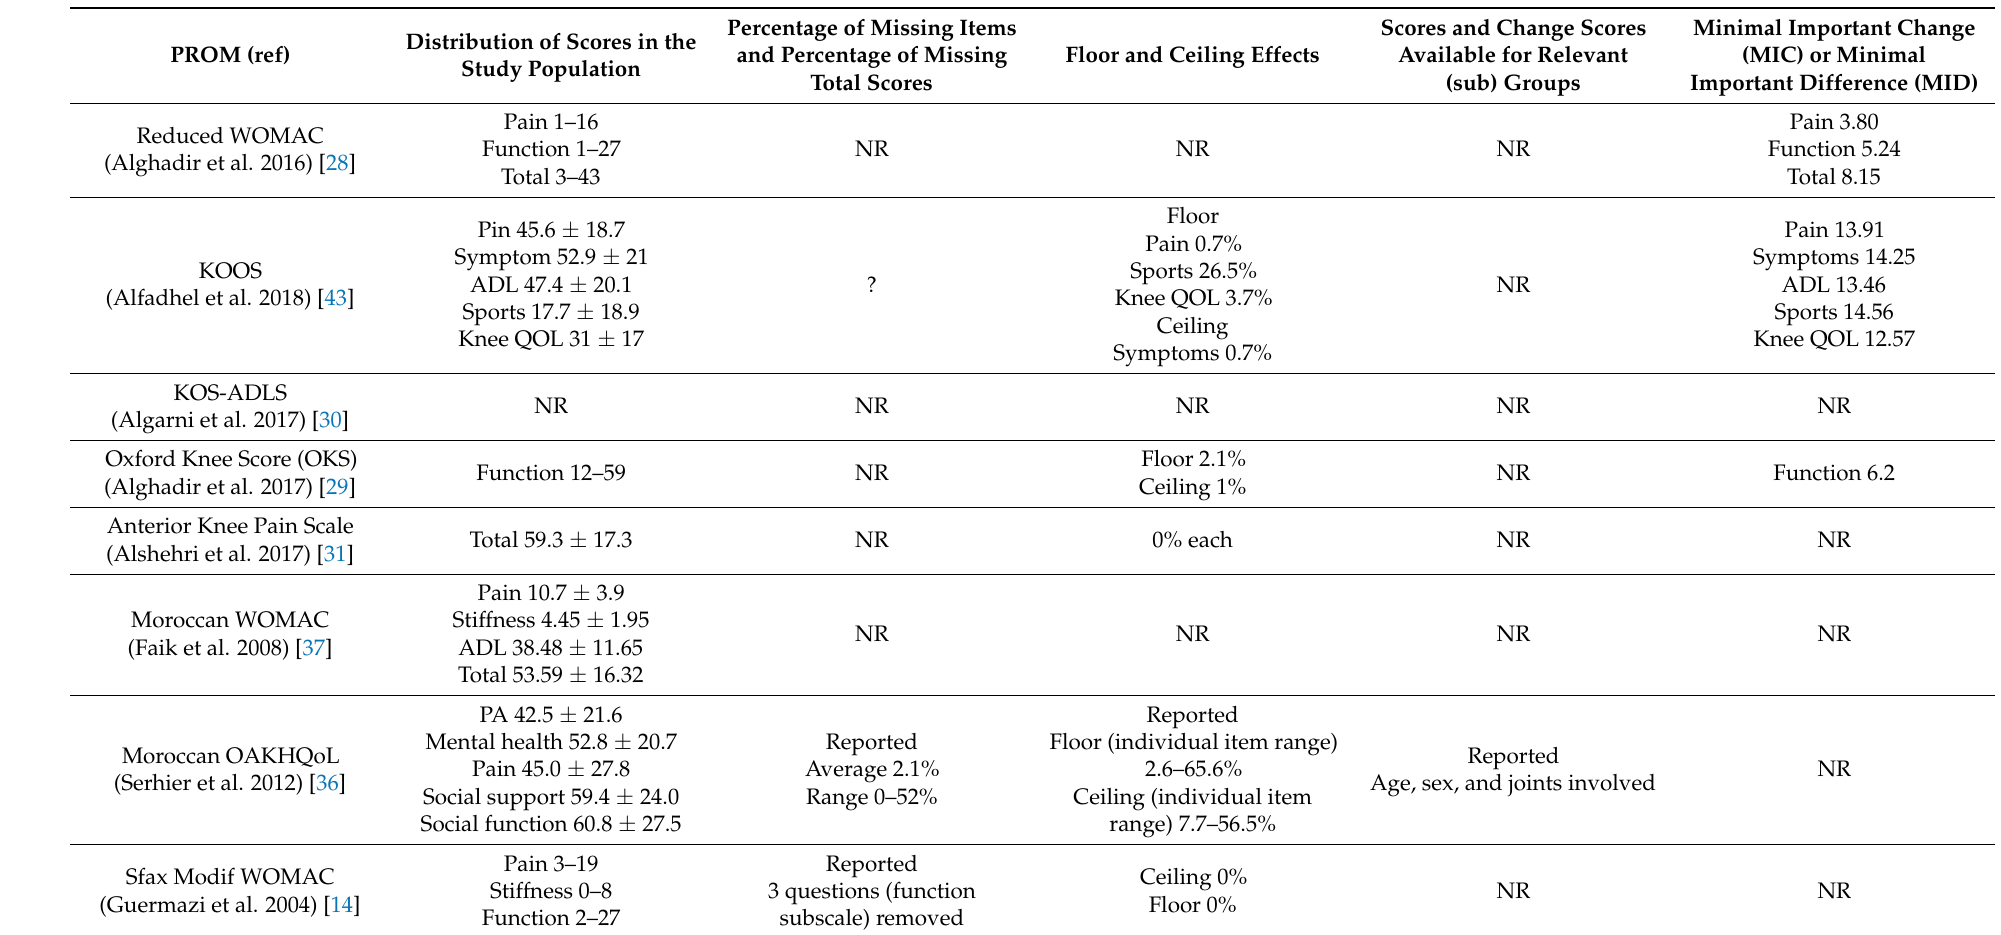
Table 3. Information to extract on the interpretability of